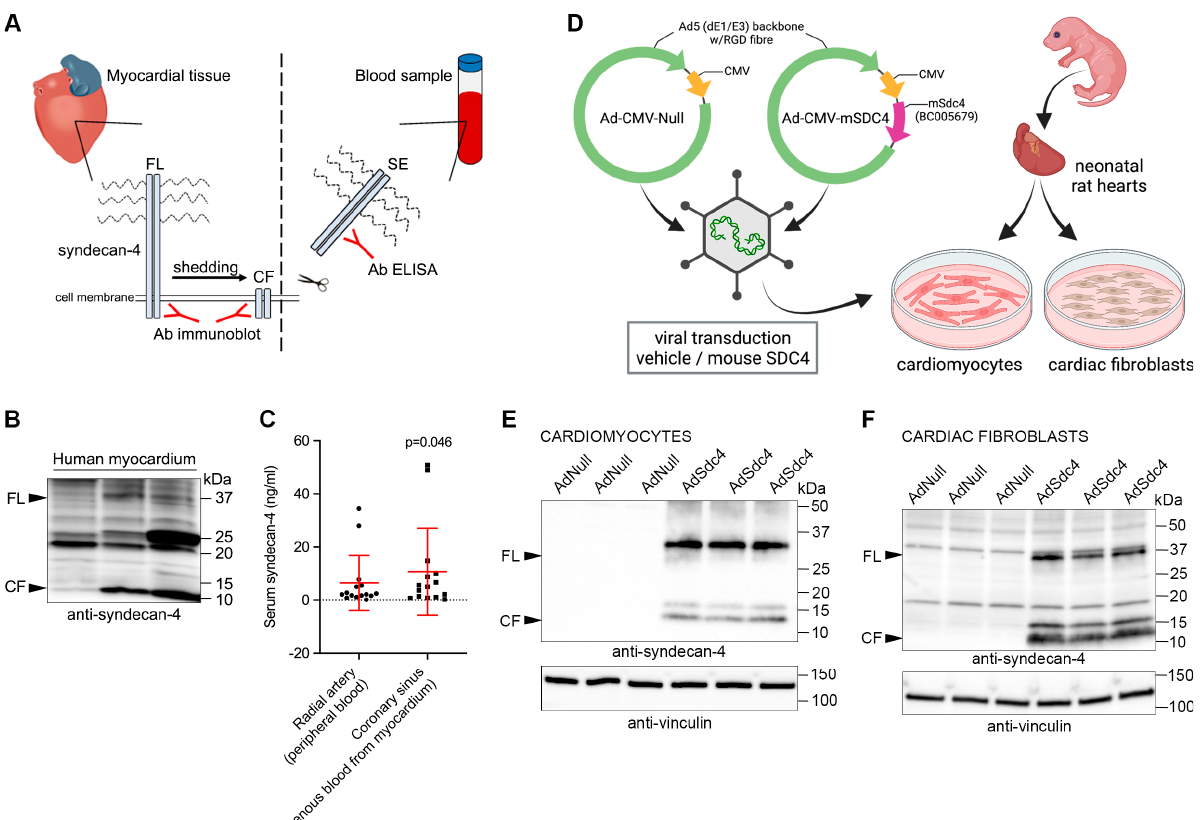
Figure 1. Syndecan-4 is shed in and from the human heart. ( A ) Schematic illustrating the antibody used to detect full-length (FL) syndecan-4 and the cellular fragment (CF) left in cells after shedding of the ectodomain, by immunoblotting of myocardial tissue or cellular protein lysates (left panel), and the antibody detecting the shed ectodomain (SE) in blood (right panel) by enzyme-linked immunosorbent assay (ELISA). ( B ) Representative immunoblot of human FL (upper arrowhead) syndecan-4 and the CF (lower arrowhead) in myectomy septum biopsies from patients with hypertrophic obstructive cardiomyopathy, n = 3. ( C ) Serum syndecan-4 levels (ng/mL) in peripheral blood from the radial artery and blood from the coronary sinus of aortic stenosis patients obtained during open heart surgery, n = 15. The numerical data supporting the graph can be found in Supplementary Table S1. ( D ) Schematic illustrating the adenoviral vectors used to transduce cultures of primary neonatal rat cardiac cells. Cells were transduced with an Adenovirus serotype 5 (dE1/E3) with RGD fiber modification encoding mouse syndecan-4 (AdSdc4) or vehicle (AdNull). ( E , F ) Representative immunoblots of mouse syndecan-4 FL and CF in primary cultures of neonatal rat cardiomyocytes ( n = 9, ( E )) and cardiac fibroblasts ( n = 12, ( F )). Vinculin was used for loading control. Data are presented as mean ± S.D. Statistical differences were tested using Student’s paired t -test ( C ). Acute MI is another condition with a high degree of inflammation. We obtained serum samples at hospital admission (day 0), and at day 3 and day 30 post-MI from each patient ( n = 119). Syndecan-4 showed slightly higher mean values at day 3 (16.29 ng/mL, p = 0.0002) and day 30 (15.78, p = 0.013) when paired statistical comparisons were made to levels at day 0 (14.39 ng/mL) in each patient (Figure 3). Thus, patients with acute MI display higher serum levels of syndecan-4 during the inflammatory phase post-MI. Of note, however, the mean and range of syndecan-4 levels (min. values of 0.86, 5.84 and 5.94 ng/mL and max. values of 32.20, 32.24 and 34.80 ng/mL at day 0, 3 and 30, respectively) in post-MI patients did not differ from the cardiomyopathy groups